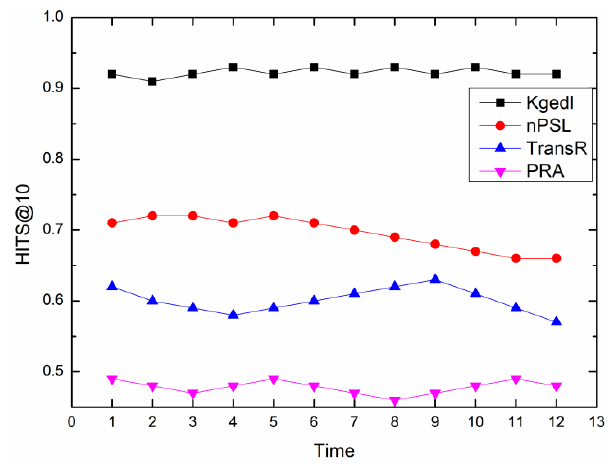
Figure 8. The performance comparison between Kgedl and three baseline methods with the metric HITS@10.